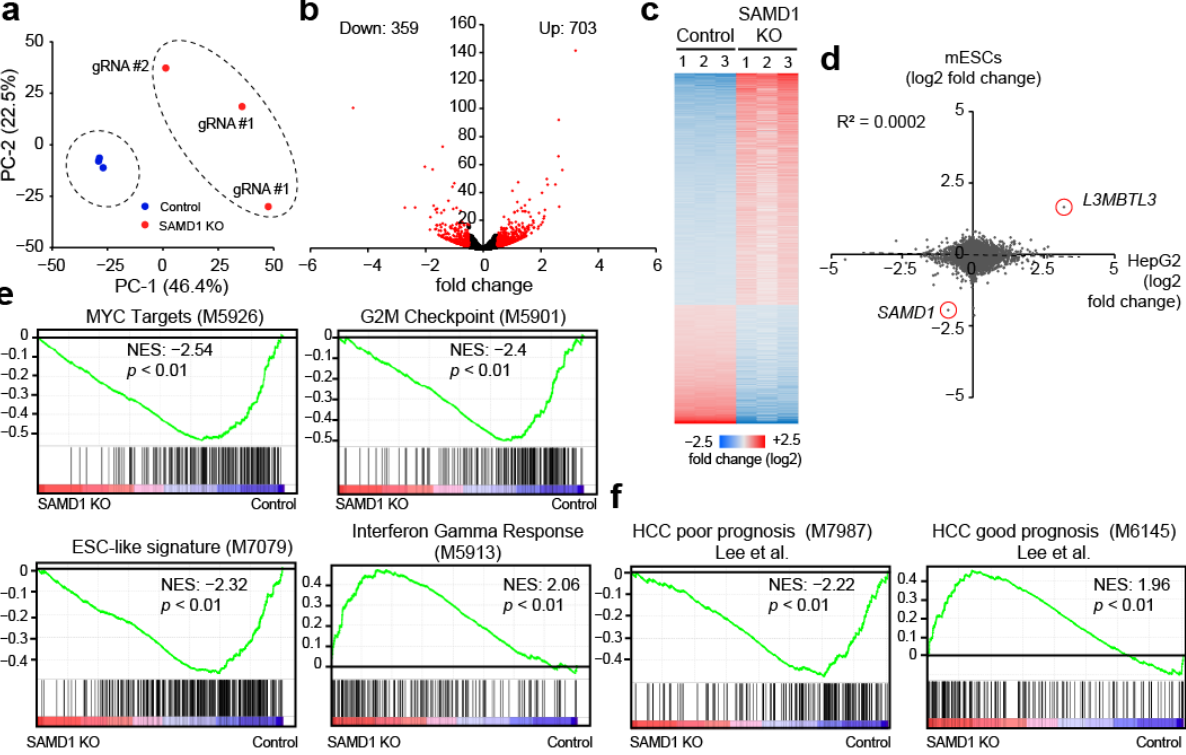
Figure 2. SAMD1 deletion leads to a more favorable transcriptional network. ( a ) Principal component analysis (PCA) of RNA-Seq data from three control samples and three independent SAMD1 KO clones (obtained with two distinct gRNAs, marked by #). ( b ) Volcano plot of RNA-Seq data. Red dots represent significantly differentially expressed genes ( p < 0.01) with a fold change larger than 0.5 (log2). ( c ) Heatmap of differentially expressed genes from ( b ). ( d ) Comparison of gene expression changes upon SAMD1 deletion in HepG2 cells and mouse ES cells. The scale depicts log2 fold change. ( e ) Unbiased gene set enrichment analysis (GSEA) of RNA-Seq data from HepG2 cells. ( f ) GSEA of a predefined gene set associated with poor or good prognosis in HCC [42] . We then asked how the change in gene expression upon SAMD1 deletion may corre- late with patient survival. Using previously curated datasets of liver cancer patients [42], we found that gene sets expressed in hepatocellular carcinoma patients with poorer prog- nosis become predominantly downregulated in SAMD1 KO HepG2 cells, while genes that